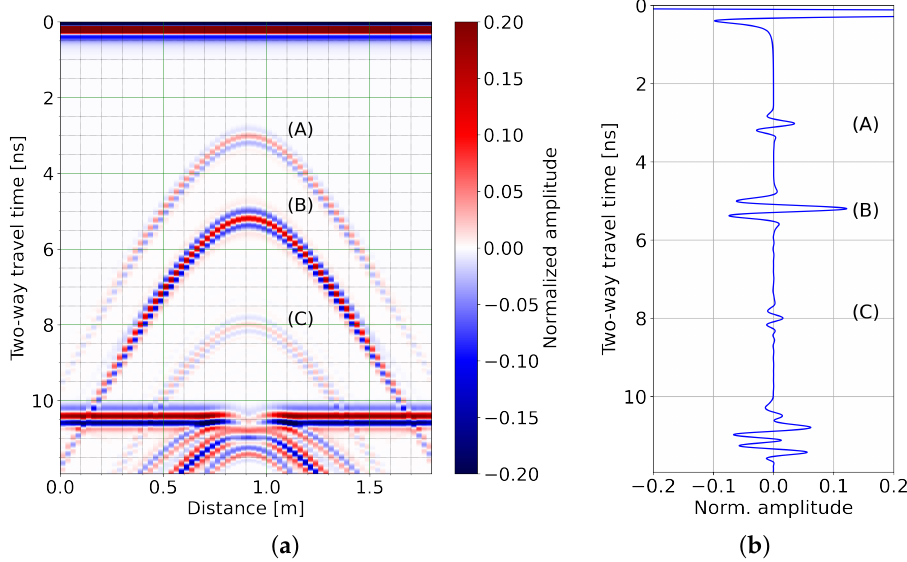
Figure 4. ( a ) Simulated radargram with the geometry of Figure 3 and ( b ) central trace acquired at 0.9 m distance from the beginning of the